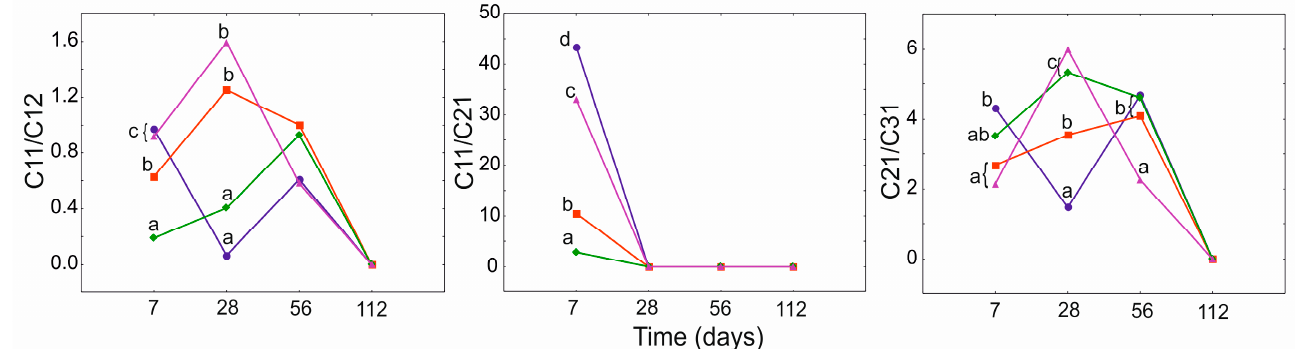
Figure 5. GLMM for geochemical ratios of heavy naphtha for PGA treatment (blue and circle—PGA 0 , red and square—PGA 1 , green and diamond—PGA 1B , violet and triangle—PGA 10 ) and time (days). The different letters indicate the pairwise differences according to Duncan pairwise test. Mean values, standard error and confidence intervals are included in Supplementary Material Table